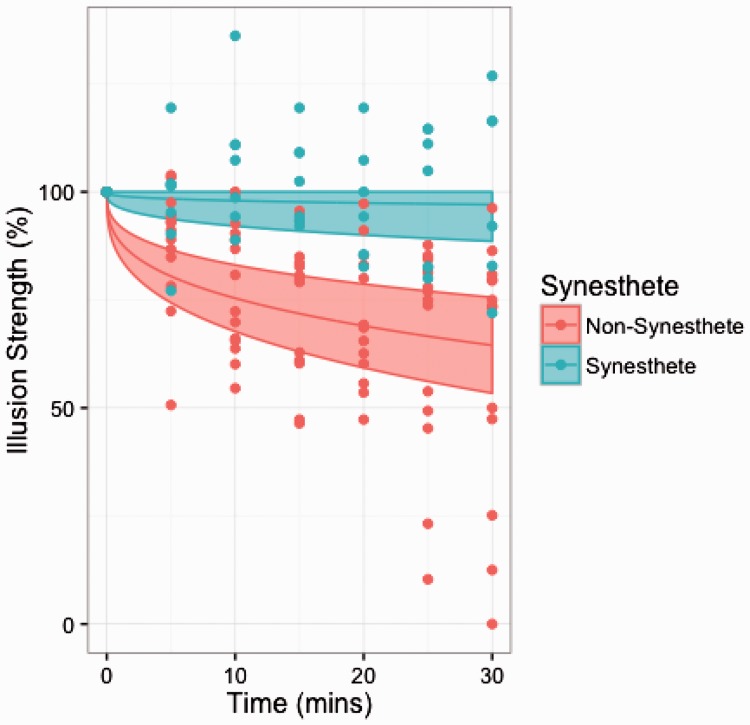
Visualized data for nonsynesthete (red) and synesthete (blue) ME decay over time (y). Groups' mean decay and 95% confidence intervals are represented linearly, individual's illusion strength at each test period are plotted with points.